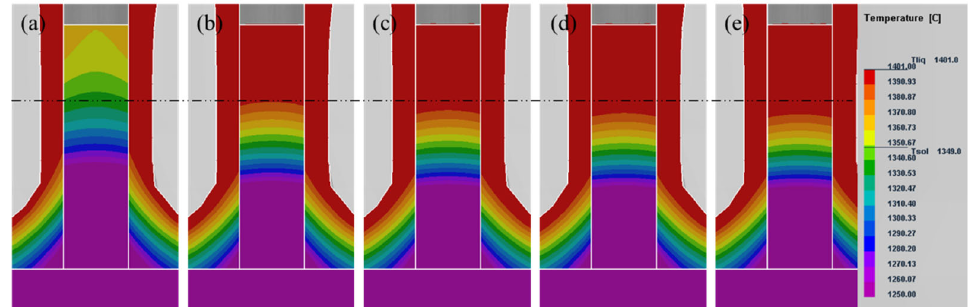
Figure 2. The temperature field of the seed segment in the heating ( a ) and holding ( b – e ) stages. ( a ) Four min prior to the holding stage, and at holding times of ( b ) 0 min, ( c ) 2 min, ( d ) 4 min, and ( e ) 8 min.